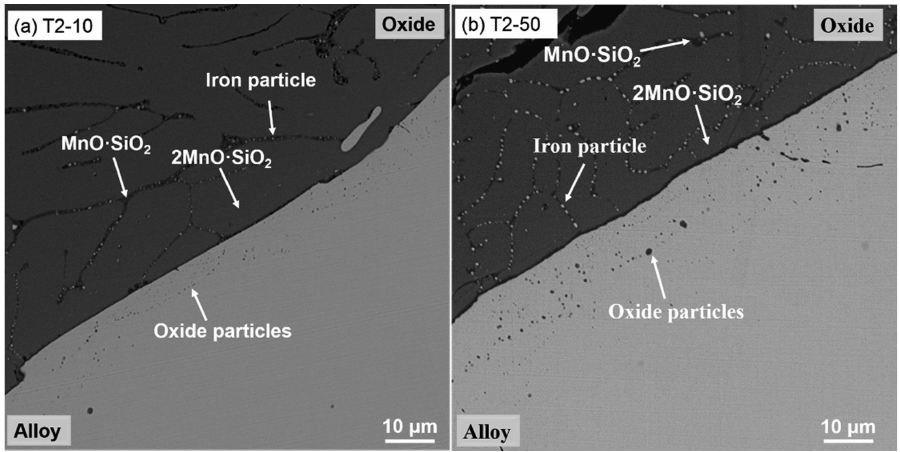
Figure 7: Morphology of the interface between the oxide and alloy after heat treatment at 1273K for (a) 10h and (b) 50h.